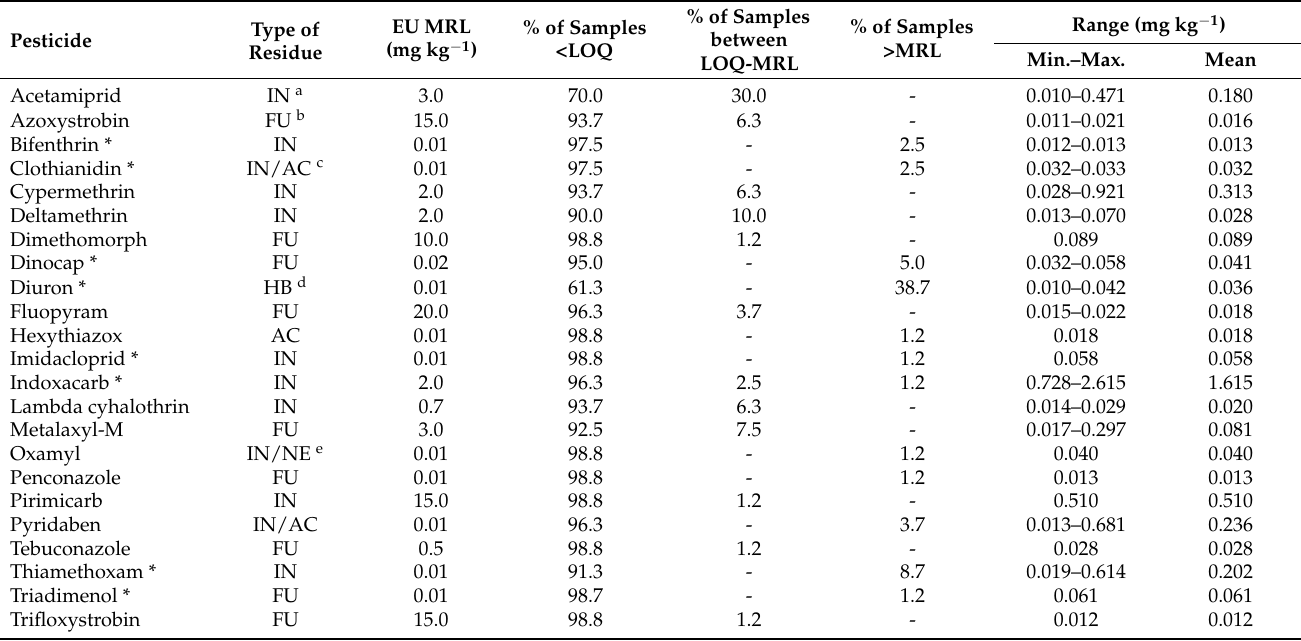
Table 3. The presence and quantification of pesticide residues in rocket.